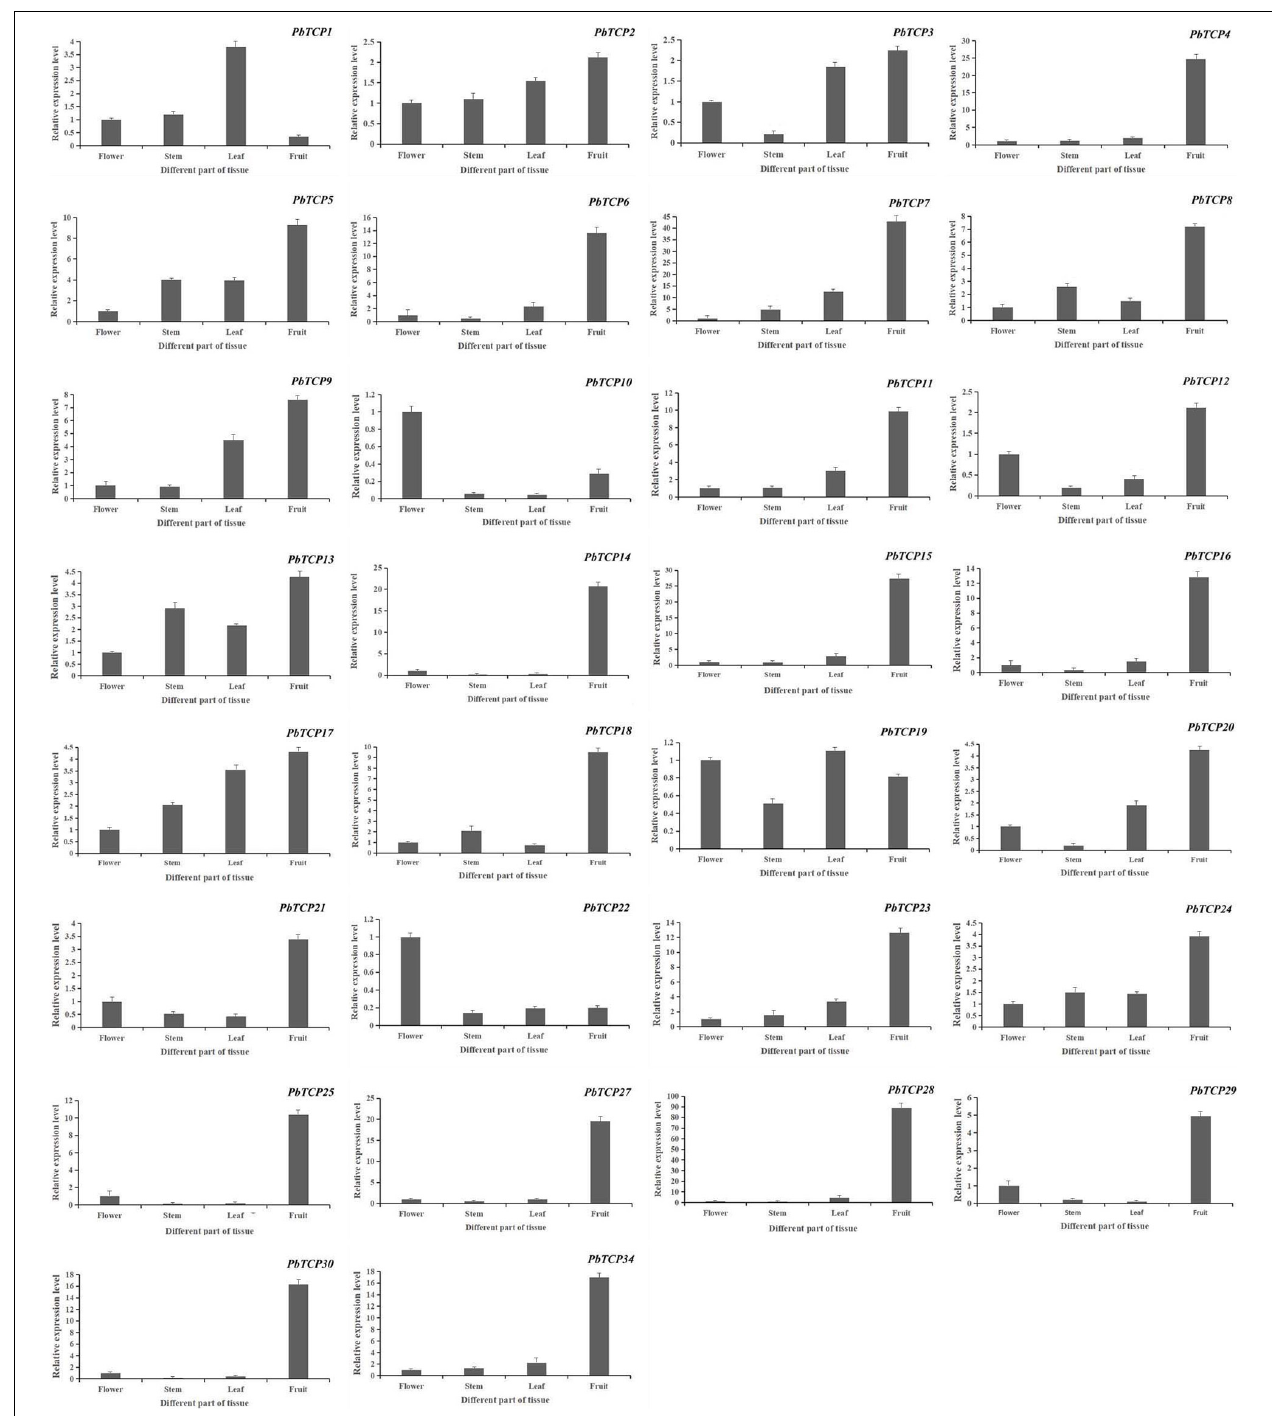
FIGURE 7 | Expression pattern of PbTCPs across different tissues (fruit, stems, flowers, and leaves). Error bars show the standard error between three